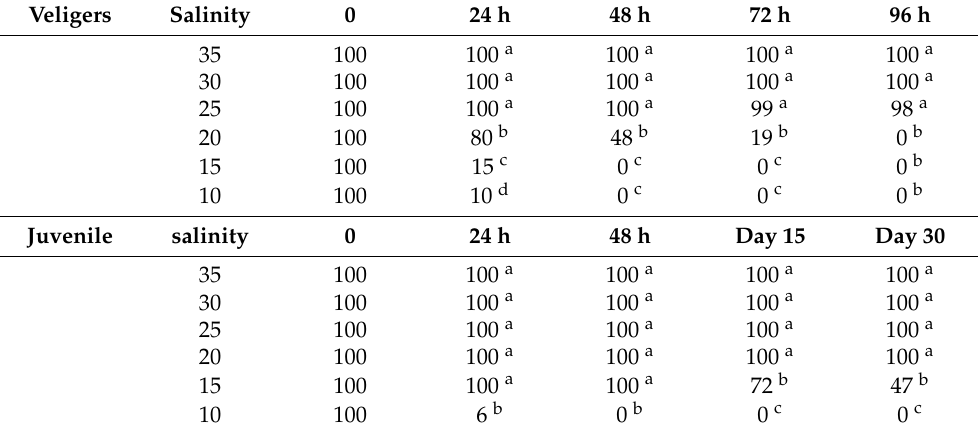
Table 1. Survival rates (%) of veligers and newly metamorphosed juveniles of Laevistrombus canarium exposed to different salinity